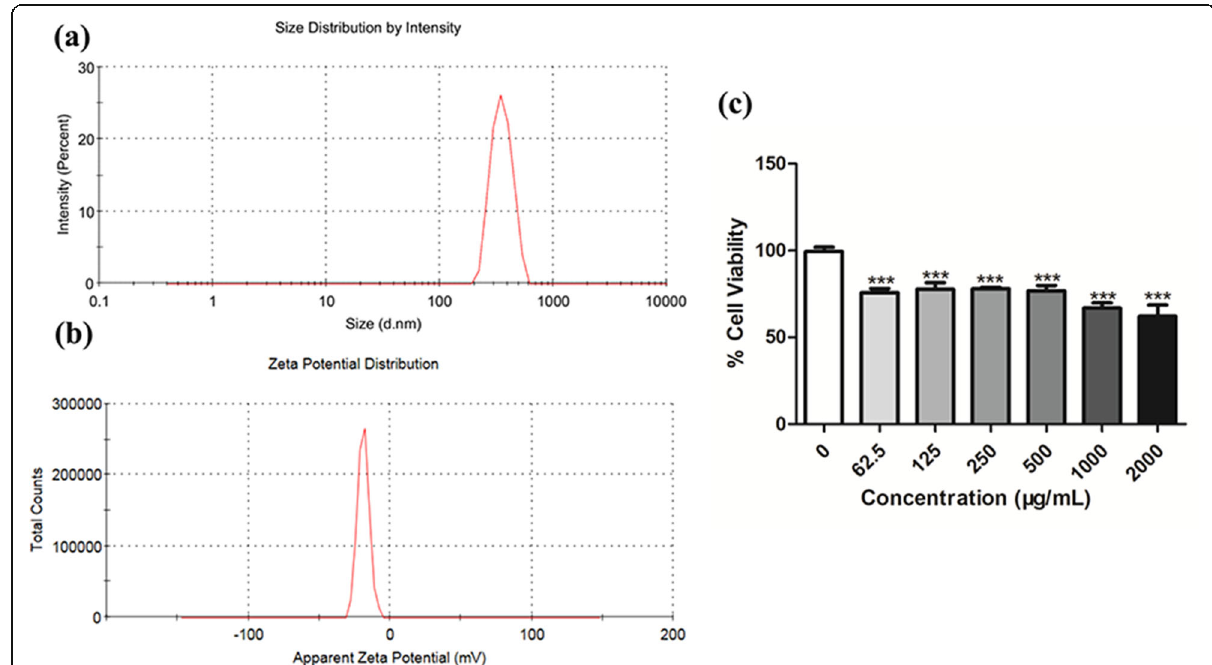
Fig. 1 Characterization of SiO 2 NPs in suspension. Particles were suspended in cell culture medium with 10% FBS. a, b Size and zeta potential of SiO